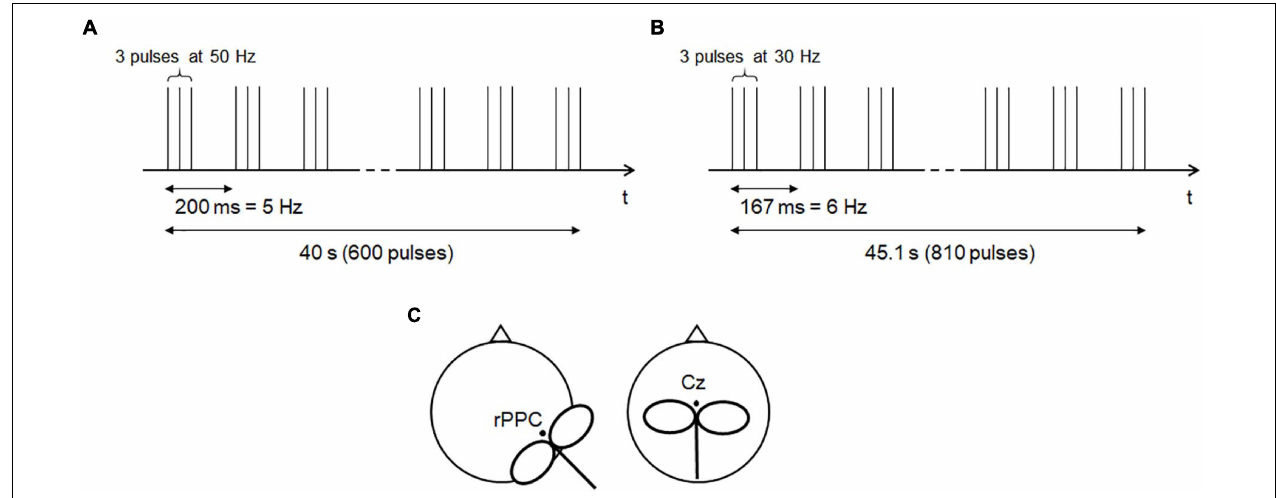
FIGURE 3 | Theta burst stimulation protocols. (A) The 50-Hz protocol (Huang et al., 2005). (B) The 30-Hz protocol, adapted from Nyffeler et al. (2006b). (C) Schematic of coil positioning.